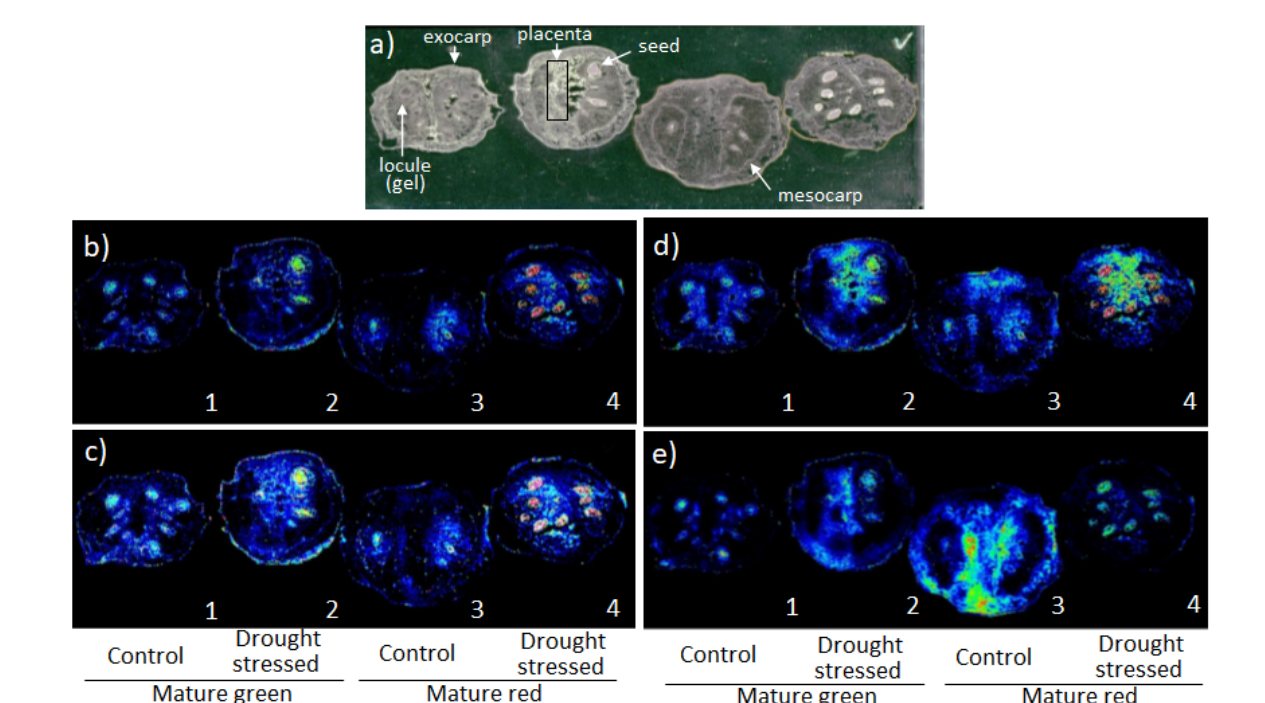
Figure 2. Mass spectrometry imaging of fatty acid and inositol distribution during ripening in tomato fruits under drought stress. ( a ) Bright-field images of control or drought-stressed fruits. ( b – d ) Mass spectrometry imaging of palmitic acid +H m / z 257 ( b ), stearic acid +H m / z 285 ( c ), oleic acid +H m / z 283 ( d ), and inositol +Na m / z 203 ( e ). Red pixels represent the highest signal intensity (100%) of the particular ion, and black pixels represent the lowest signal (0%). For interpretation of the references to color in this figure legend, the reader should refer to the web version of this